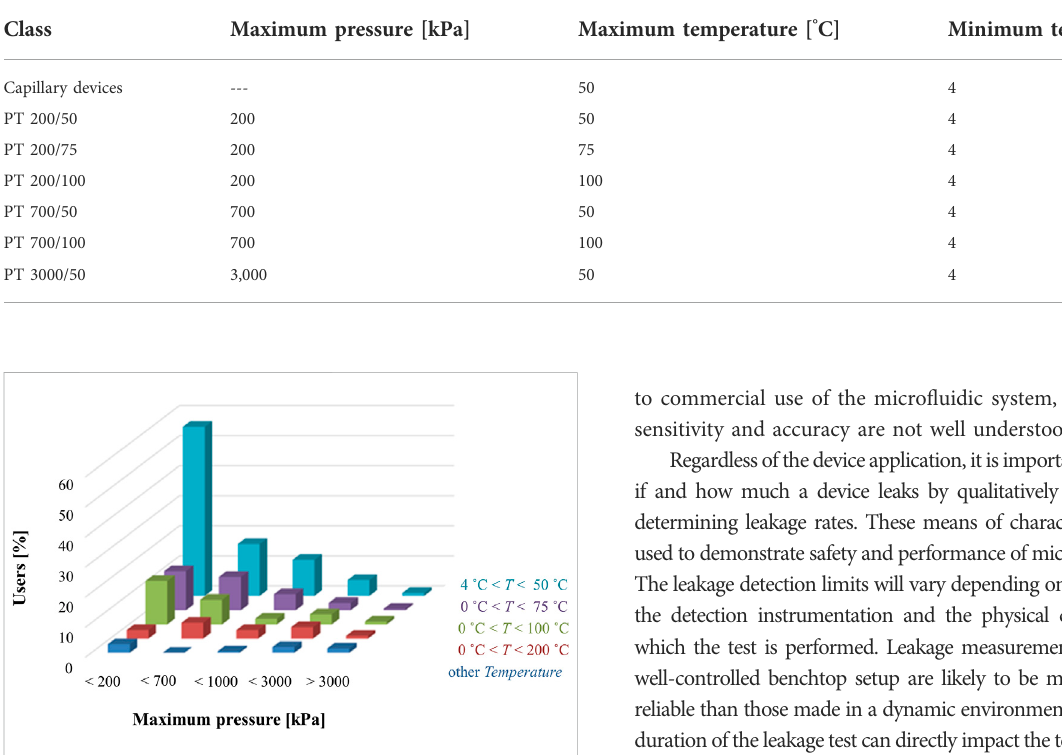
FIGURE 4 Distribution of micro fl uidic applications based on the operating temperature and pressure classes (The Micro fl uidics Association, 2016).